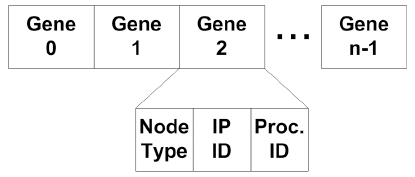
Fig. 4. Chromosome encoding for IP assignment